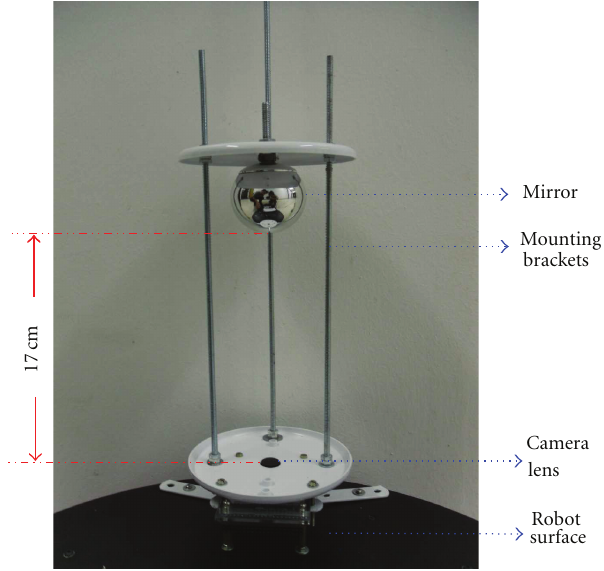
Figure 3: Main components of the proposed catadioptric system.